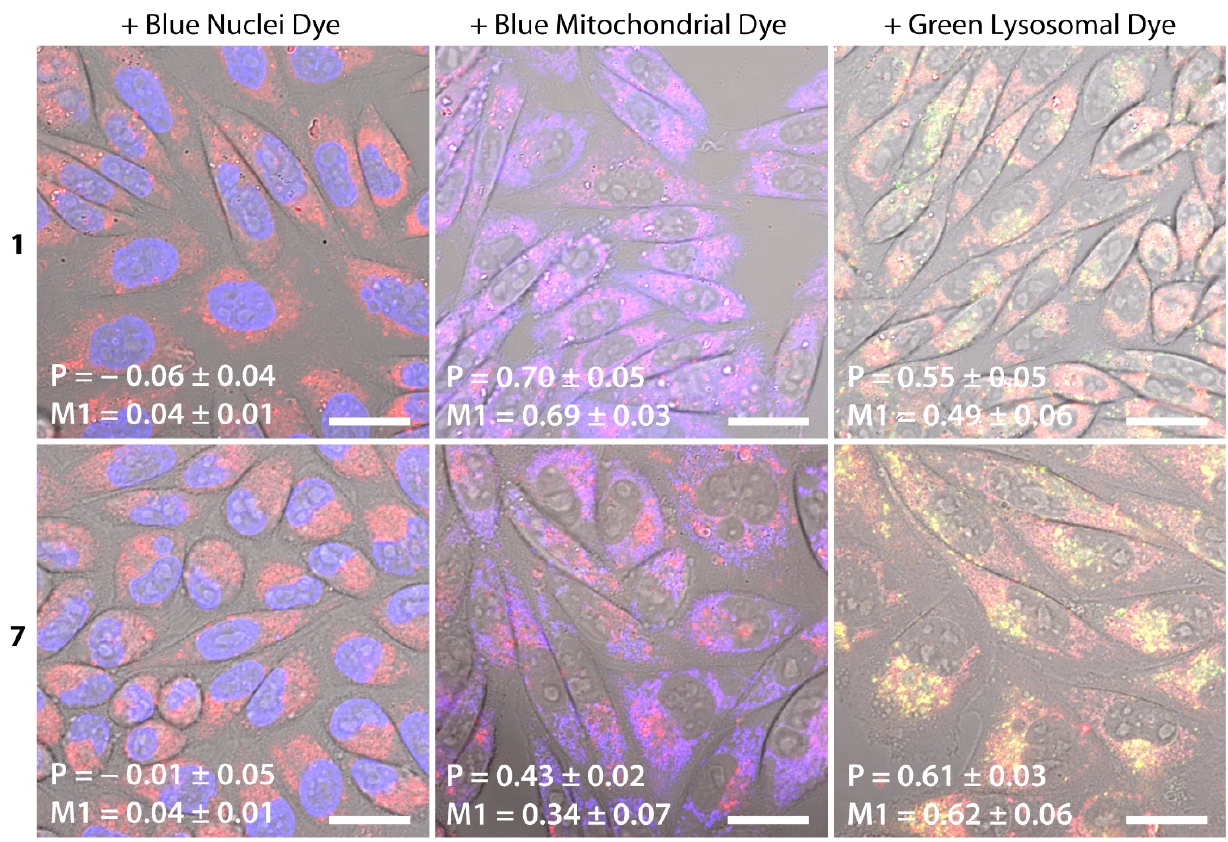
Figure 6. Subcellular distribution of 1 (5 µM, 1.5% of PEG-200) and 7 (10 µM, 2.5% of PEG-200) in CHO-K1 cells (red color). Cells were co-stained with the complexes for 24 h and organelle-specific probes for nuclei: Hoechst 33324 (left), mitochondria; BioTracker 405 Blue Mitochondria Dye (central), lysosomes; LysoTracker Green DND-26 (right). Pearson’s (P) and Manders’ overlap coefficients (M1, the tracker signal overlaps the complex) are presented as mean ± standard deviation calculated for 50 cells.